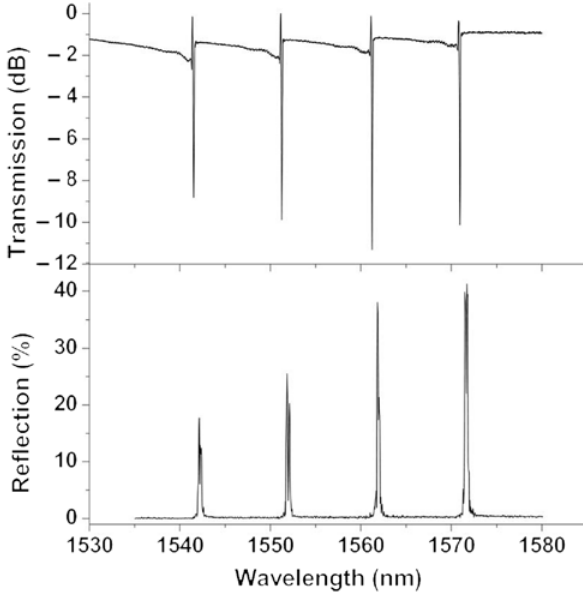
Figure 3: Spectra of four serially cascaded WBGs. The different Bragg resonances were creating by slightly altering the sample translation speed during PbP fabrication. Reprinted with permission from